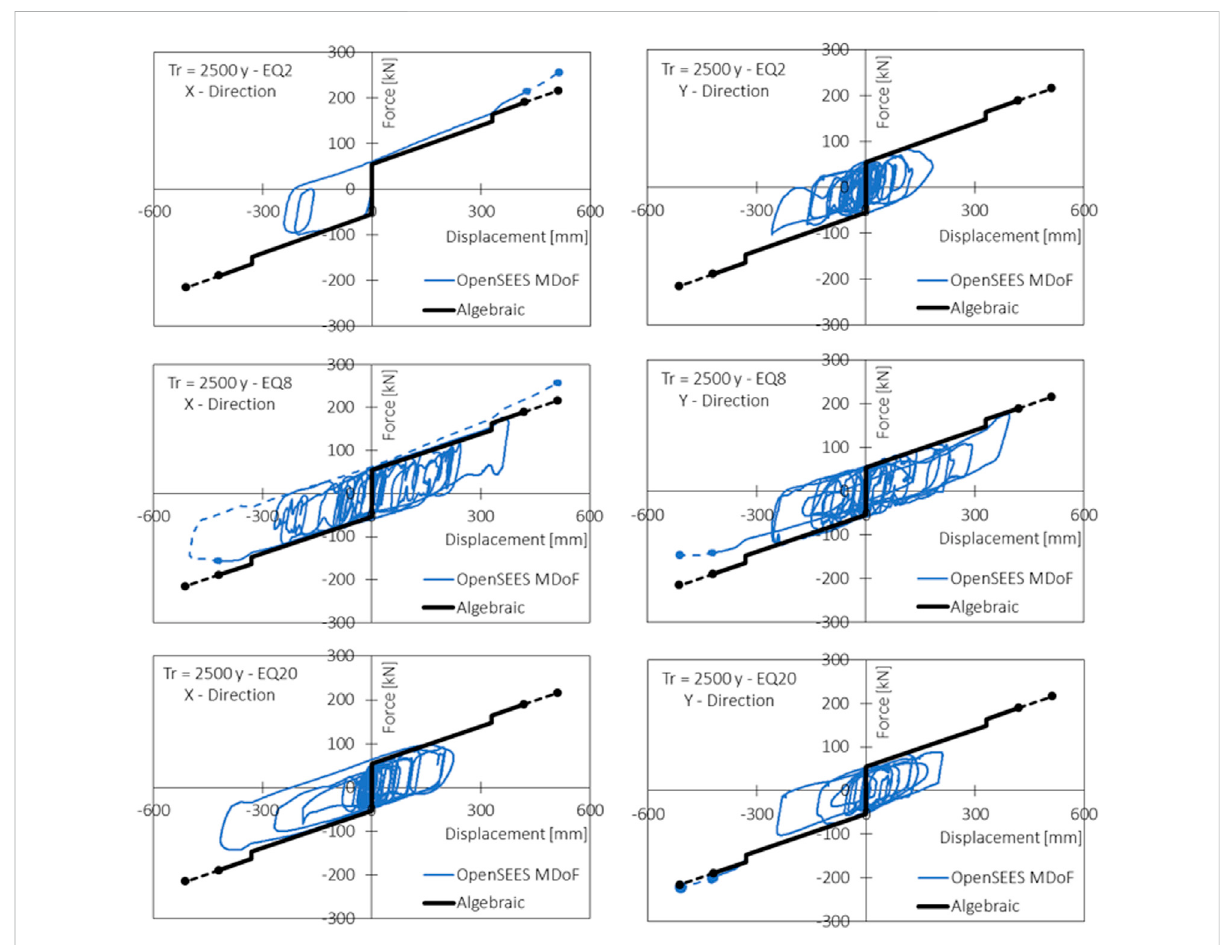
FIGURE 13 Single DCCSS bearing force vs. displacement relationship in X and Y directions for three example earthquakes (EQ2; EQ8; EQ20 for a return period of 2,500 years.